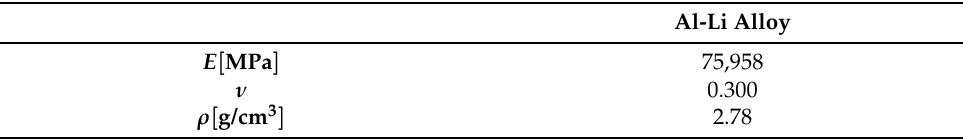
Figure 3. Geometry—Section A with all the dimensions in mm. Table 1. Mechanical properties of the AL-Li